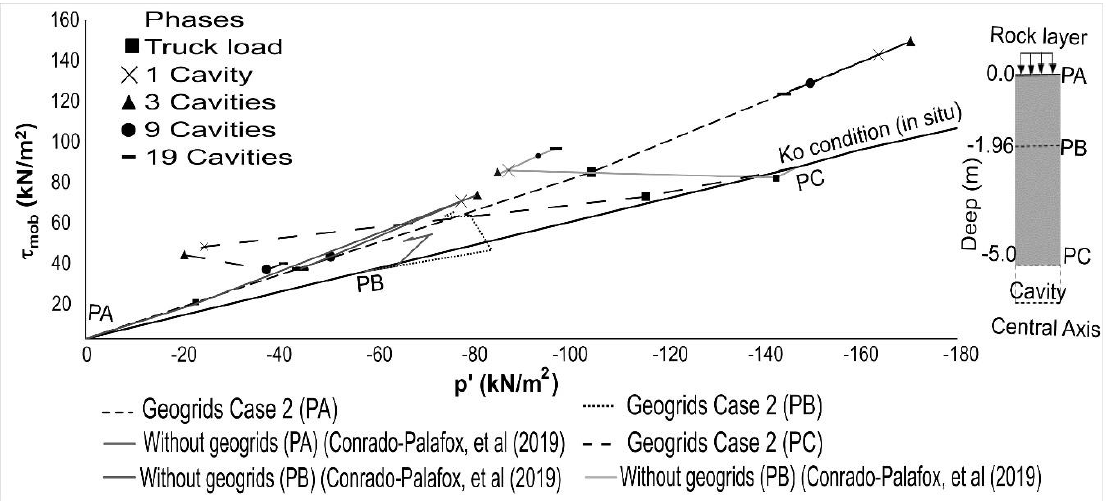
Figure 13. Stress paths in the rock layer for three different depths in the middle of the numerical, Case 2 ( N 1 , y = 0.0 m and N 2 , y = 0.31m) and without geogrids [3], considering the truck load and 3, 9 and 19 cavities.